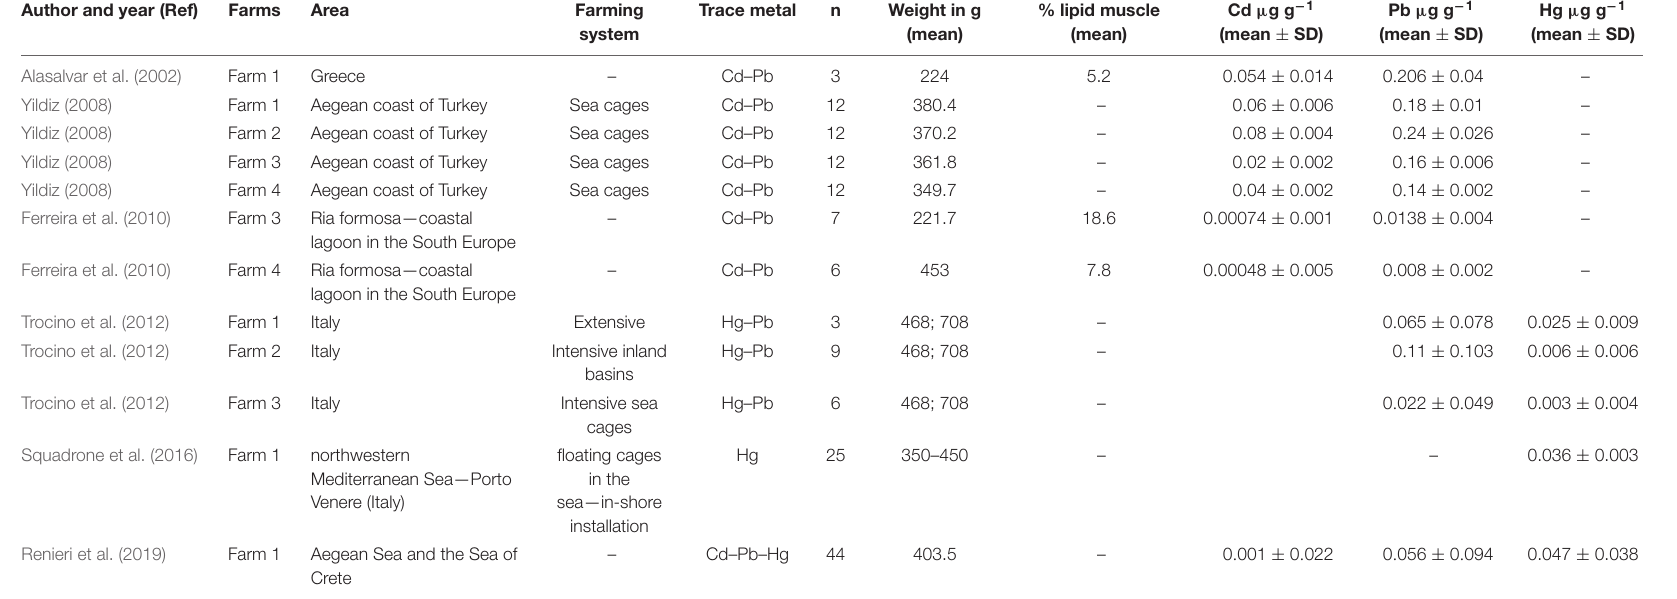
TABLE 1 | Character istics of the studies included in the meta-analysis for estimate of the concentration of cadmium, lead, and mercury. Author and year